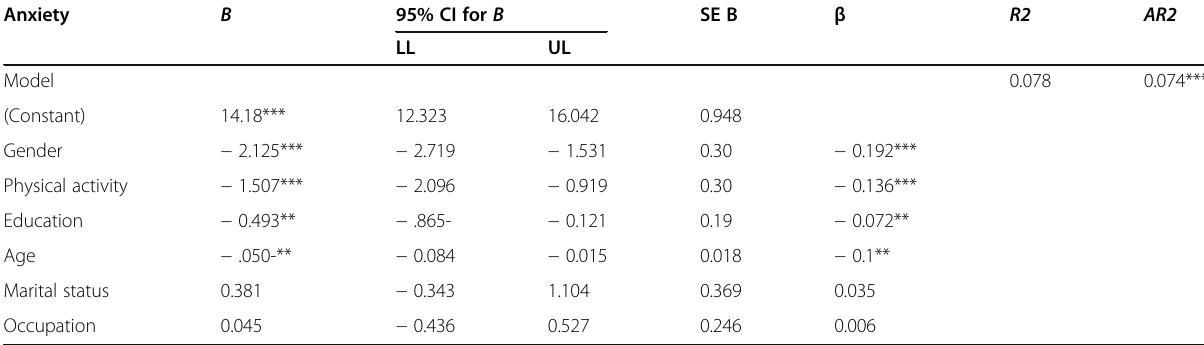
Table 4 Multiple regression results for anxiety